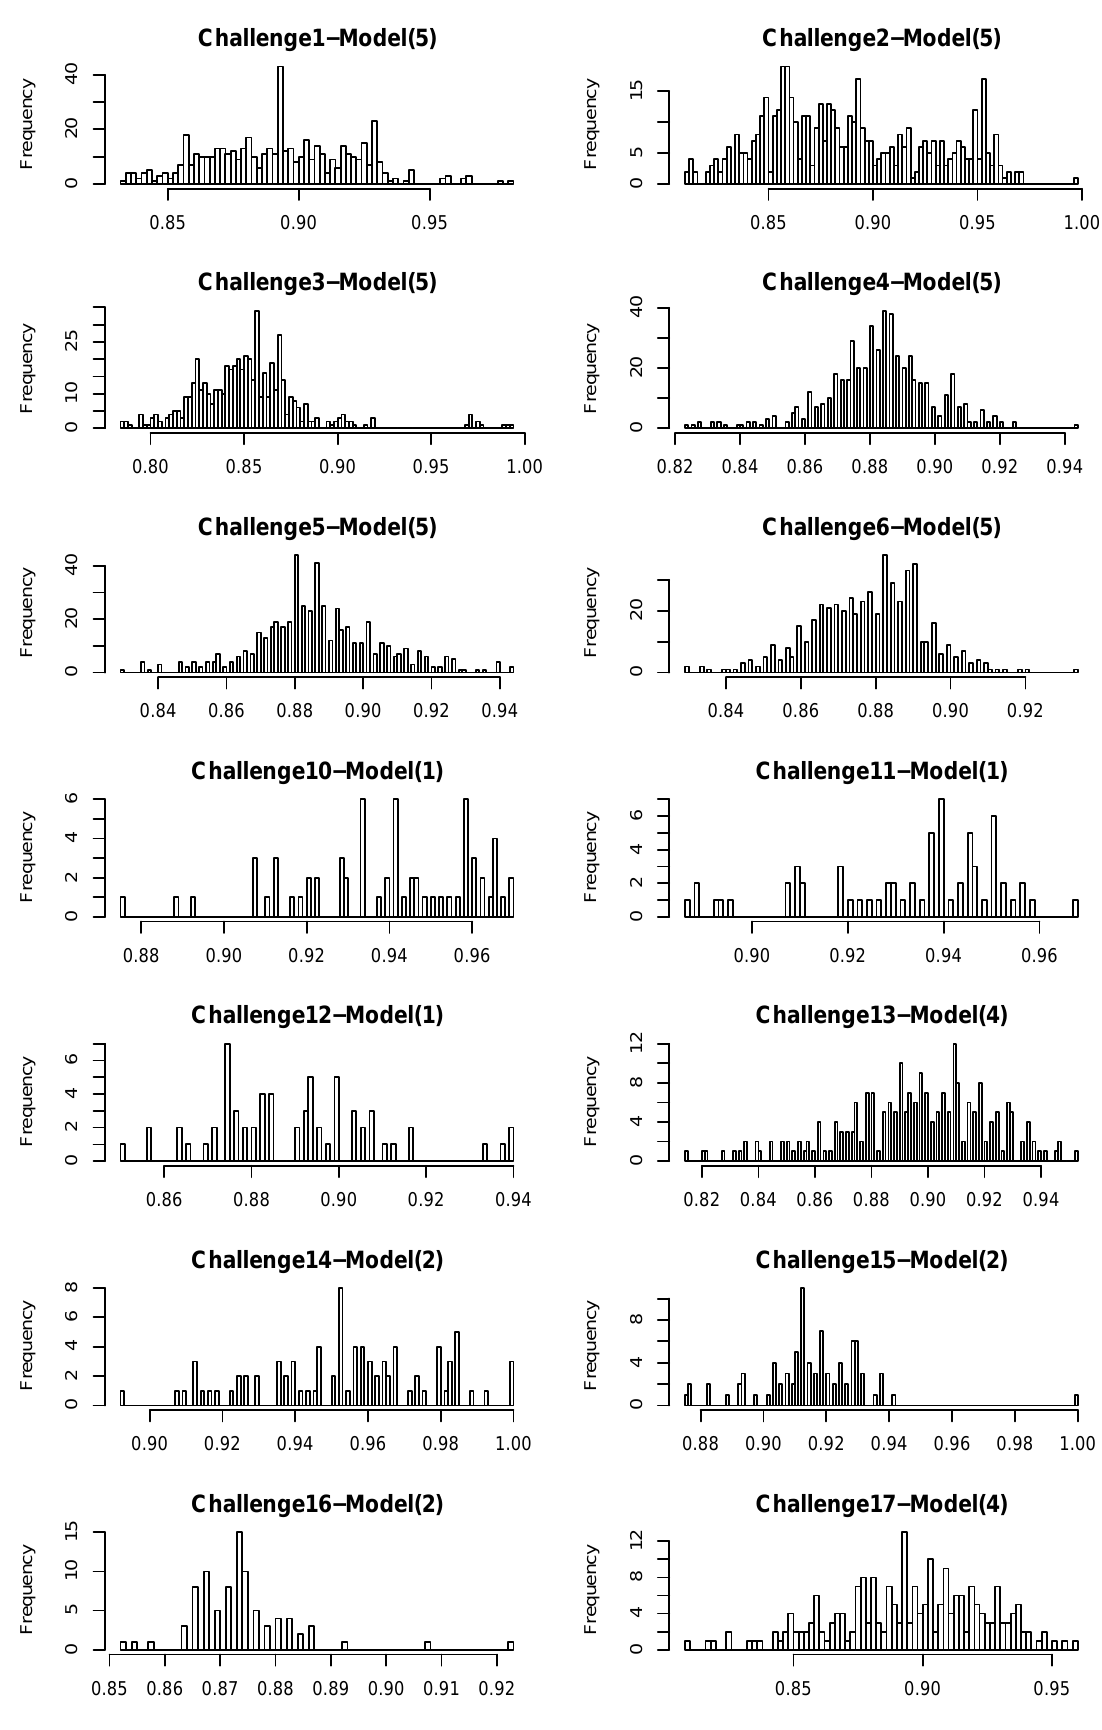
Figure A1. Distribution of similarity scores between challenge molecules and training data (used to predict the